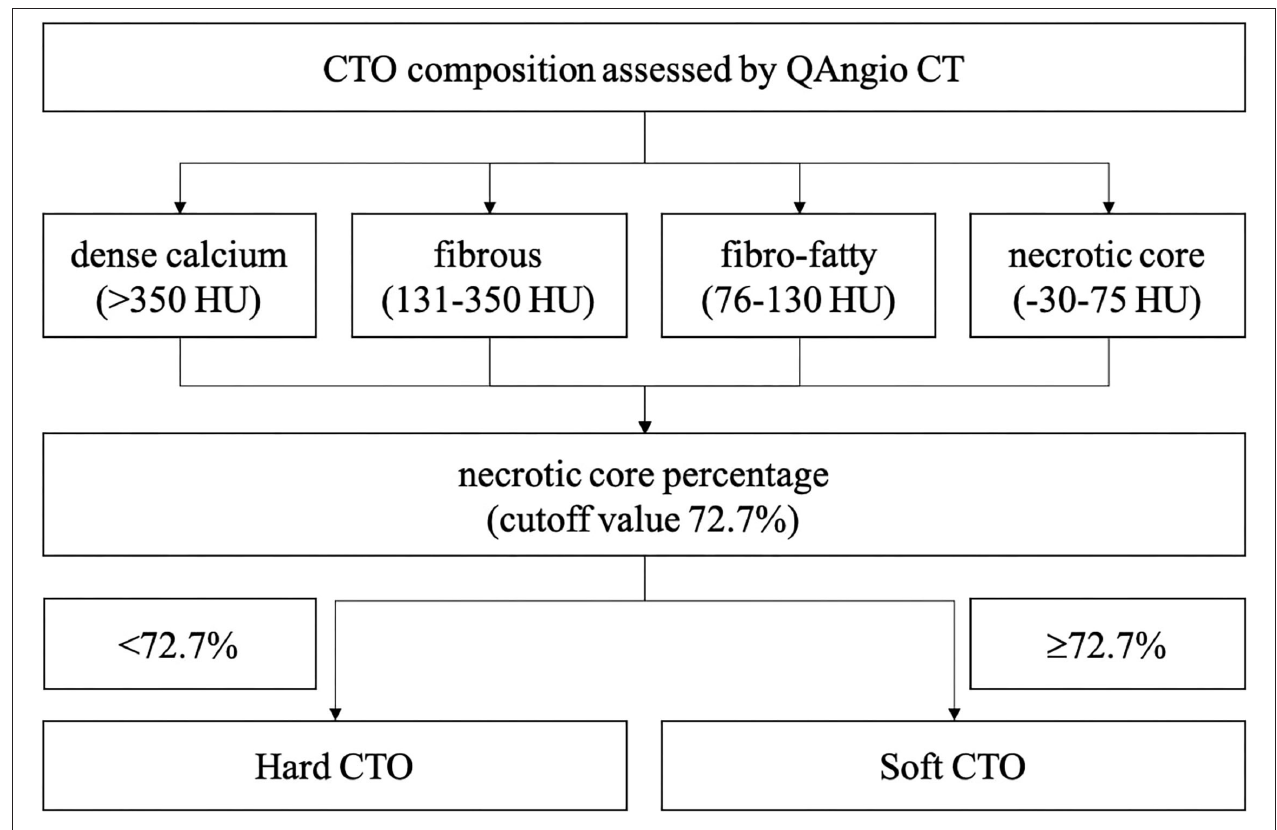
FIGURE 1 | Chronic total occlusion (CTO) classification